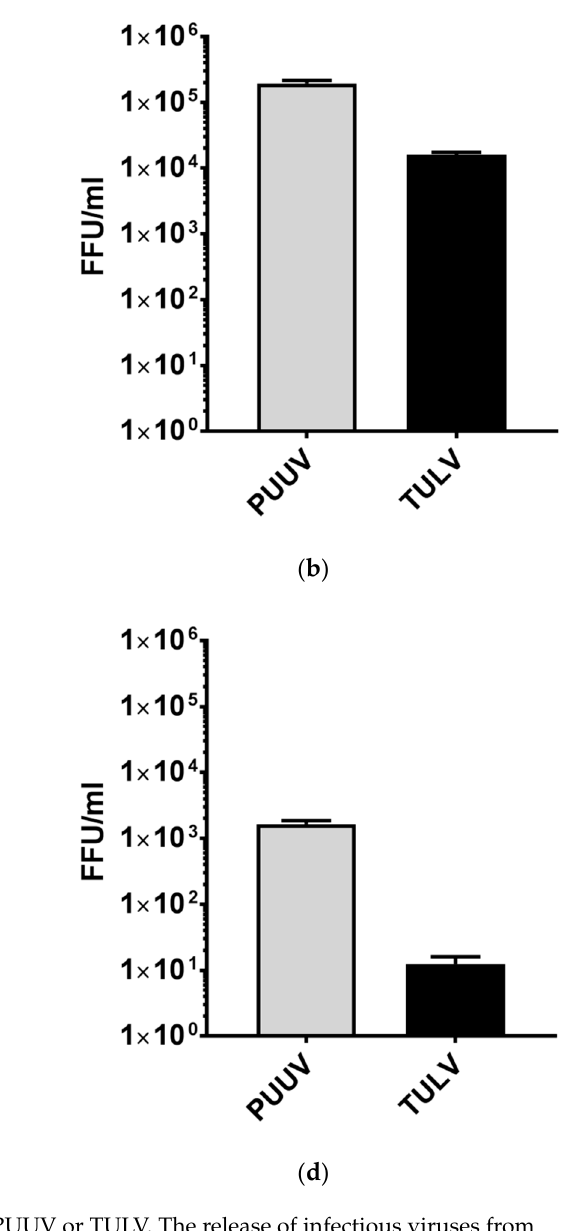
Figure 3. Progeny virus titers at 6 d p.i. with PUUV or TULV. The release of infectious viruses from PUUV- or TULV-infected ( a ) Vero E6, ( b ) A549, ( c ) HMEC-1, and ( d ) THP-1 / PMA cells were quantified by focus forming unit (FFU) assay. Cells were infected with a MoI = 0.1 and infectious viruses were quantified in cell-free cell culture supernatants at 6 d post infection.